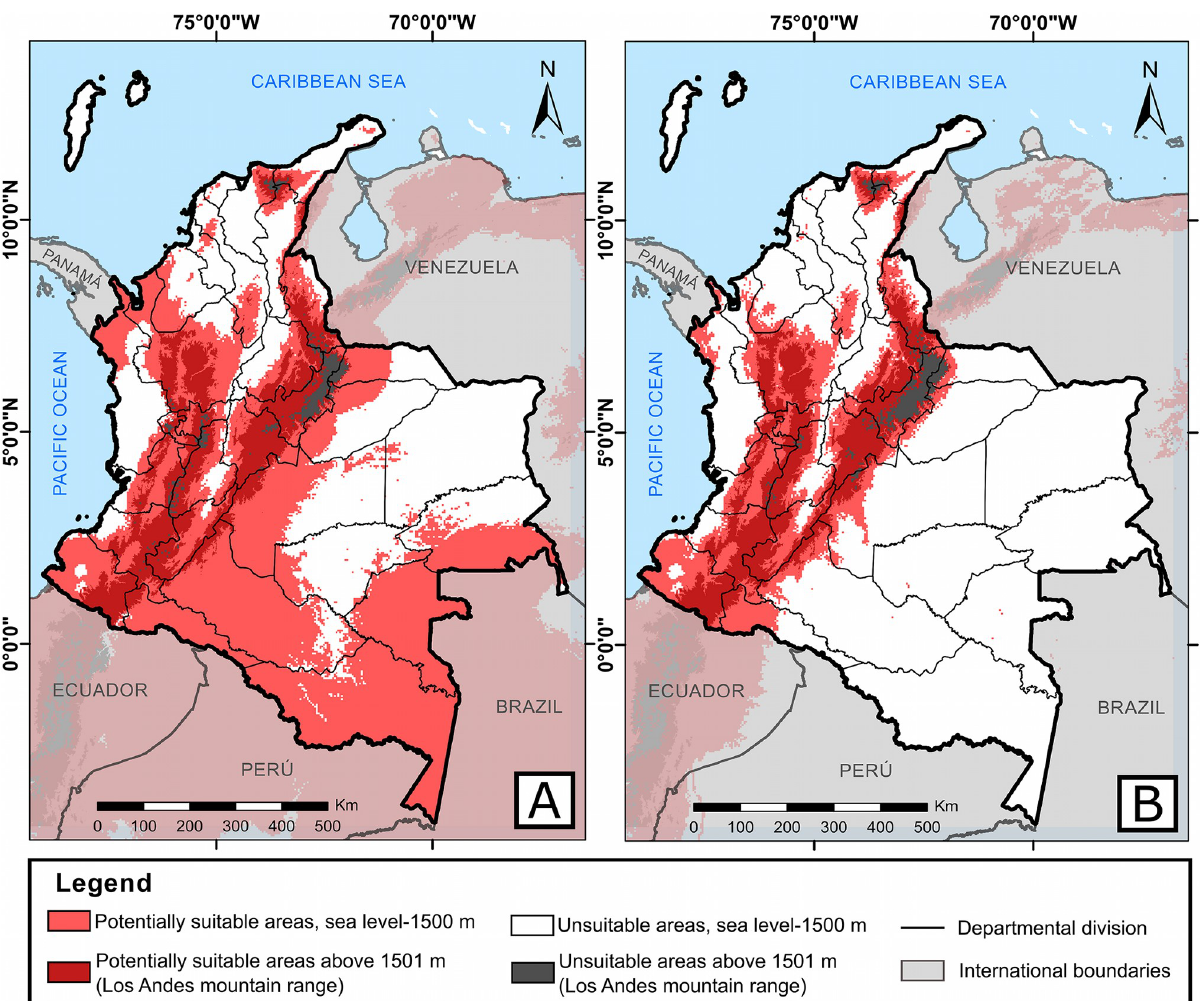
Fig 4. Potentially suitable areas to distribution of A . albopictus within a context of climate change for: A. 2050 and B. 2070, under the RCP 8.5 emission scenario. The light red corresponds to binary threshold. The maps were built using the free and open source QGIS software version